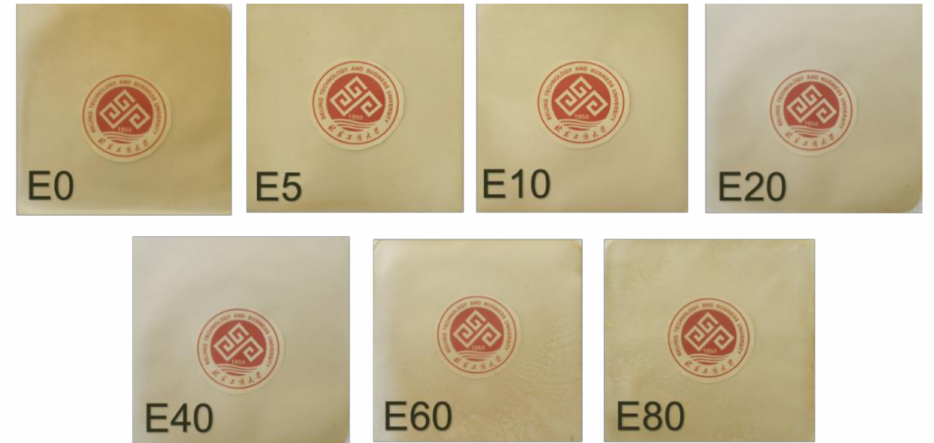
Figure 5. Photos of etherification modified poplar hemicellulose films.